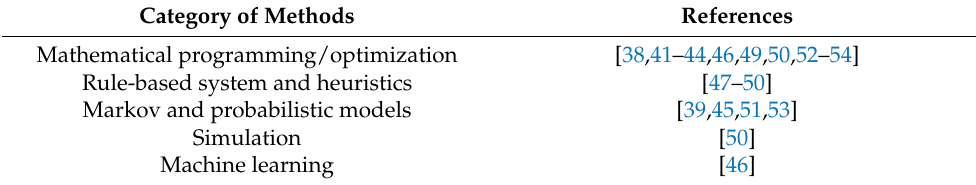
Table 7. Methods for joint scheduling and planning.